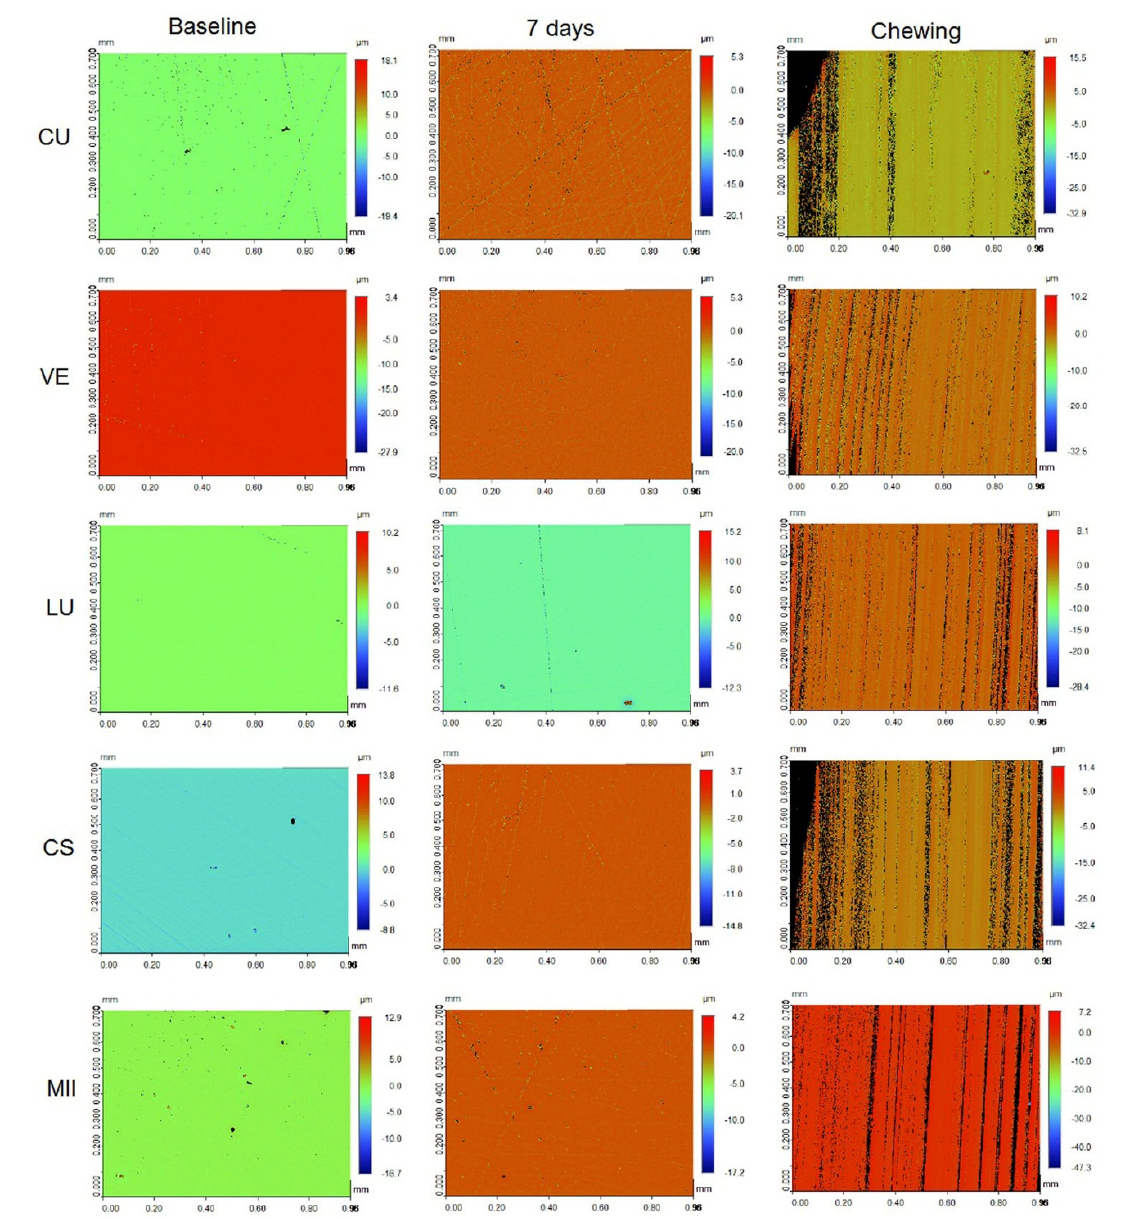
Figure 5. Profilometer images of the CAD/CAM specimens immersed in artificial saliva at different measurement intervals.